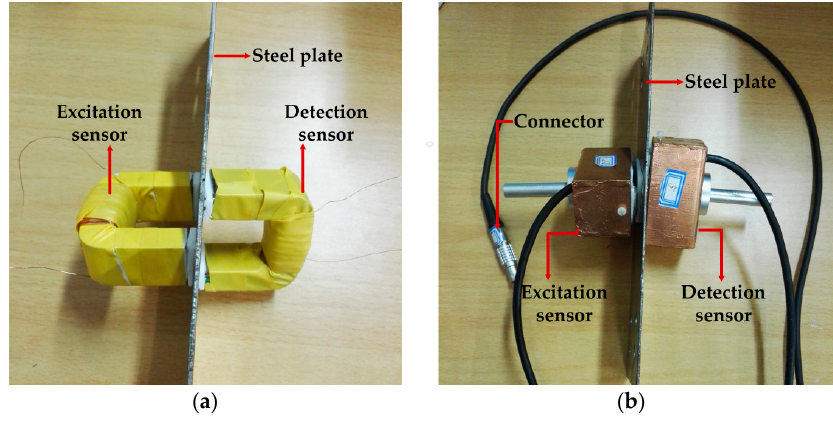
Figure 4. The installation diagram of the excitation sensor and detection sensor: ( a ) the sensors without magnetic shielding; ( b ) the sensors with the magnetic shielding and connector.